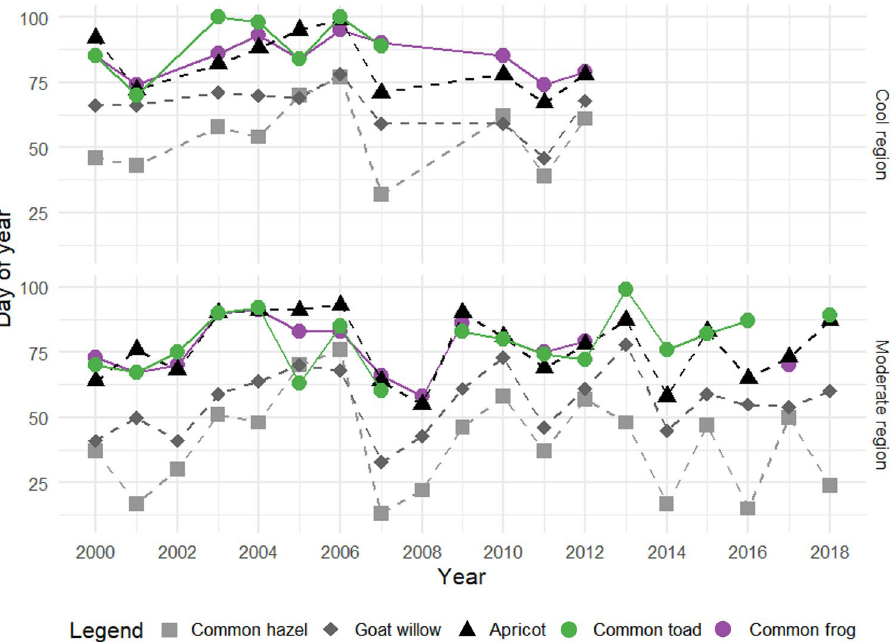
Figure 1. Earliest migration observation of common toads and common frogs and plant phenological phases of common hazel, goat willow and apricot in cool and moderate climate regions in Austria between 2000 and 2018, data missing for some years. Time series of European larch, horse-chestnut, silver birch and snowdrop in Supplementary Fig.